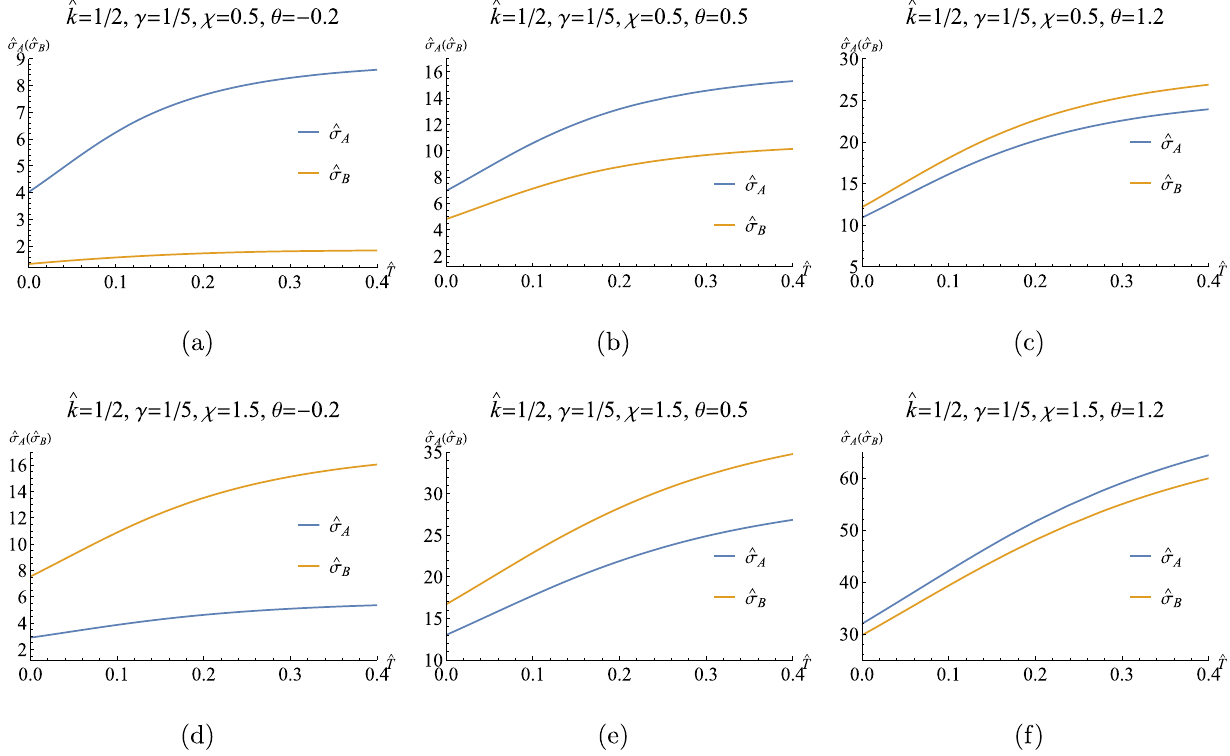
Fig. 5 Electric conductivities ˆ σ A and ˆ σ B as a function of the temperature ˆ T . Here, we’ve specified ˆ k = 1 / 2 ,γ = 1 / 5 ,χ = 0 . 5 , 1 . 5 ,θ = − 0 . 2 , 0 . 5 , 1 .